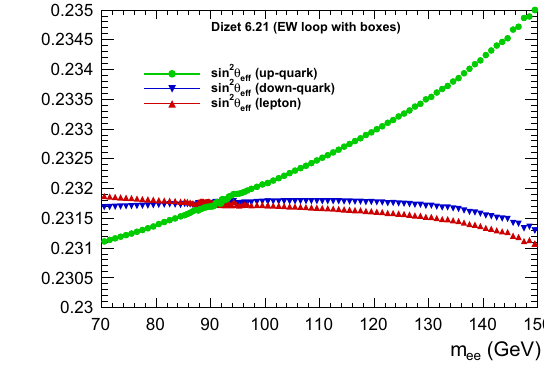
library and on-mass-shell s 2 is shown, imaginary part of I 2